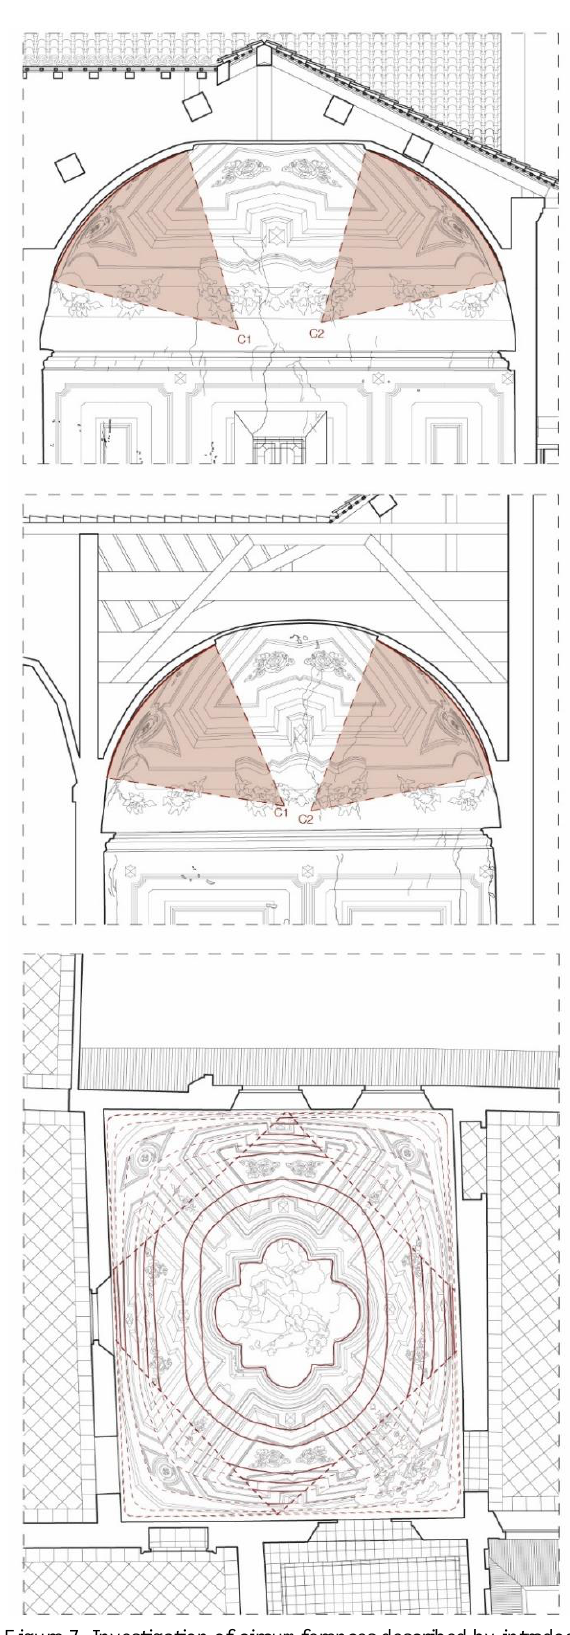
Figure 7. Investigation of circumferences described by intrados profiles along a vertical section of the vault and horizontal slicing extraction.